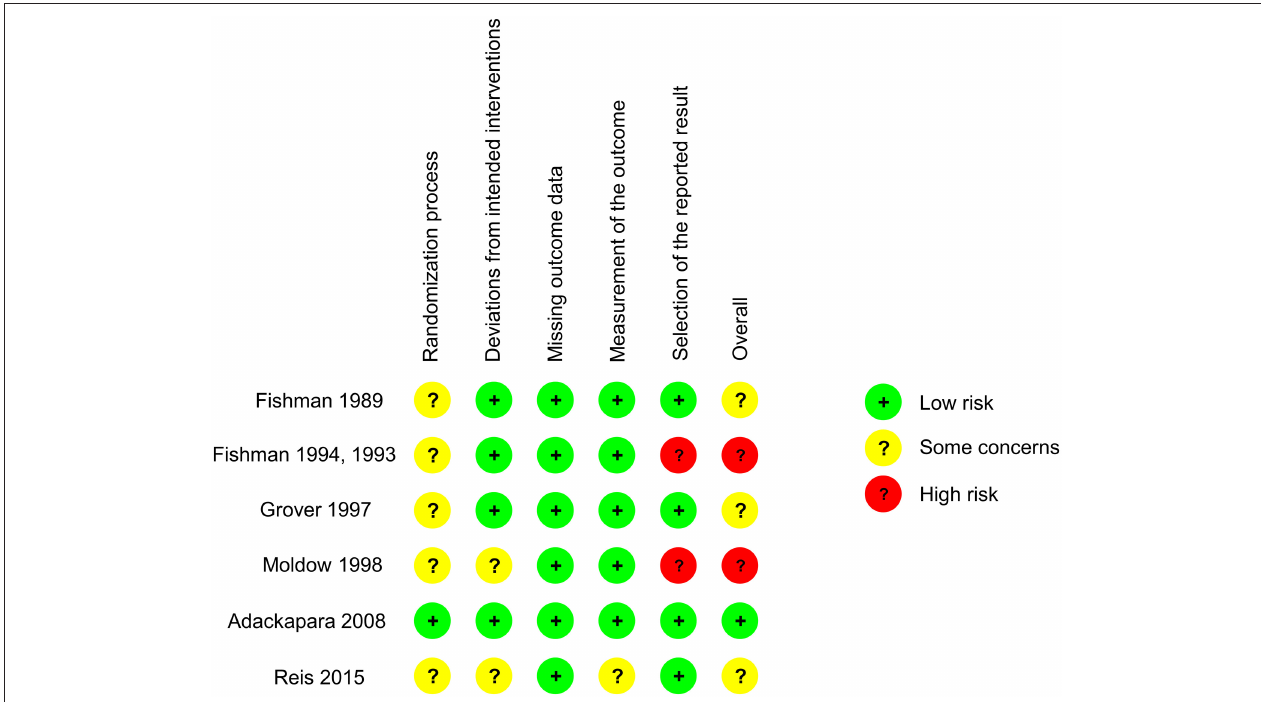
FIGURE 3 | Summary of risk of bias assessment for randomized controlled trials (RCTs) employing RoB 2